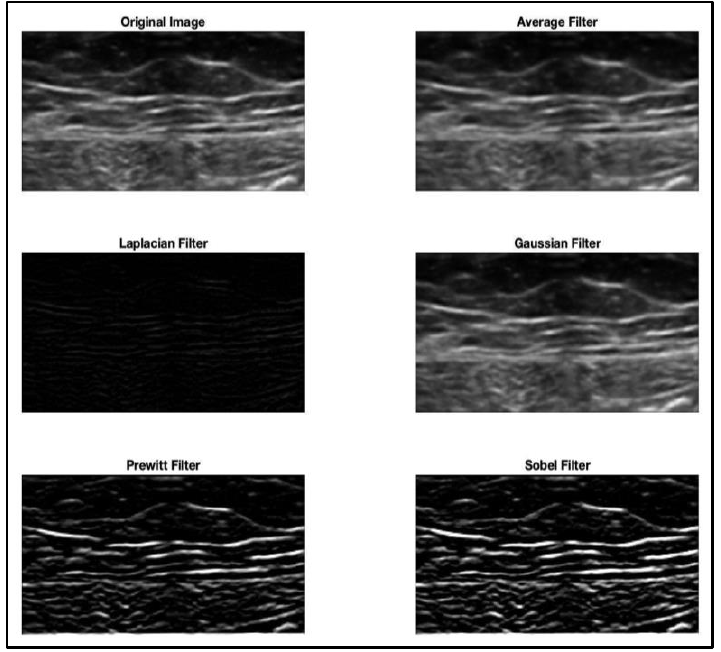
Figure 2. Image pre-processing: filtering techniques applied to the native image. Table 3. The most implemented pre-processing techniques. Computational